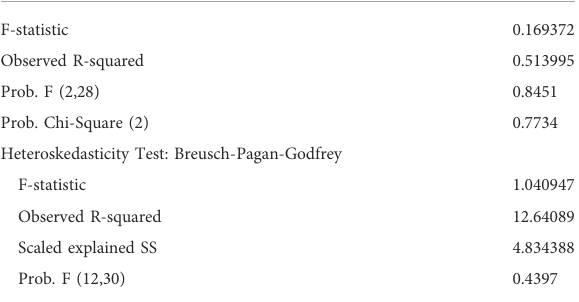
TABLE 11 Diagnostic tests results.